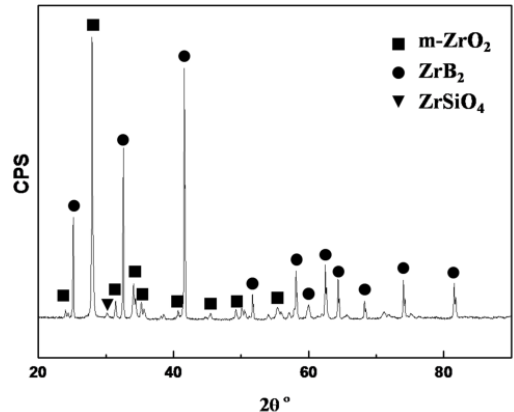
Figure 2. X ‐ ray diffraction (XRD) of the sample surface afterablation for 20s.